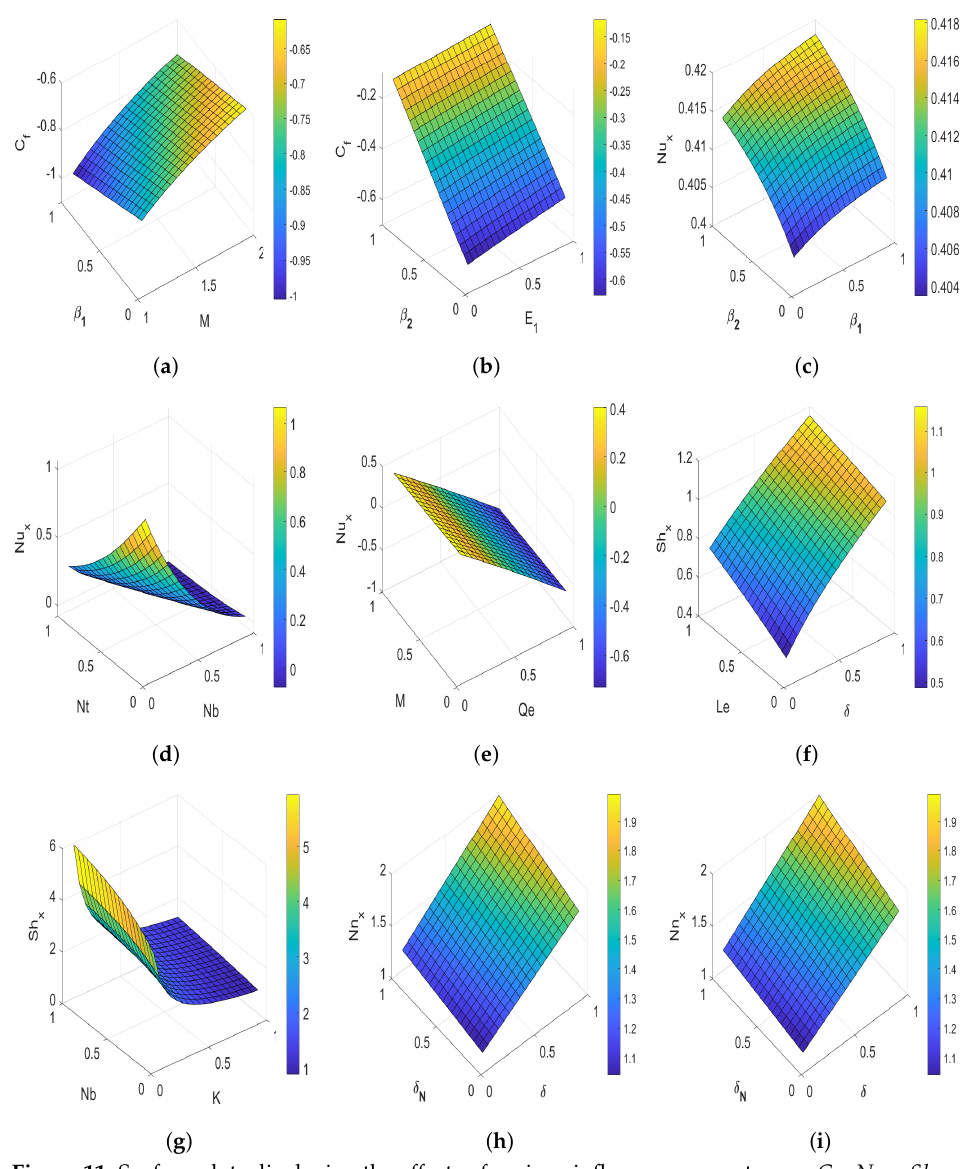
Figure 11. Surface plots displaying the effects of various influence parameters on C f , Nu x , Sh x , and Nn x . ( a ) C f versus M and β 1 ; ( b ) C f versus E 1 and β 2 ; ( c ) Nu x versus β 1 and β 2 ; ( d ) Nu x versus Nt and Nb ; ( e ) Nu x versus M and Qe ; ( f ) Sh x versus δ and Le ; ( g ) Sh x versus K and Nb ; ( h ) Nn x versus δ and δ N ; and ( i ) Nn x versus Pe and Lb